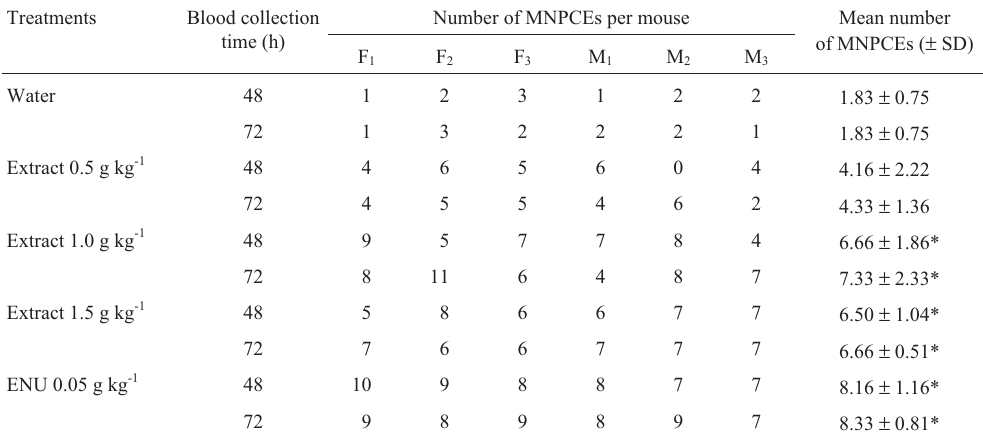
Table 4 - Micronucleus (MN) test results showing the number of micronucleated polychromatic erythrocytes (MNPCEs) in peripheral blood samples from female (n = 3; F 1 , F 2 and F 3 ) and male (n = 3; M 1 , M 2 and M 3 ) Swiss mice treated with a Piper cubeba seed extract. For each blood collection time 2000 cells were scored per mouse. SD = standard deviation. Negative control = water, positive control = N-nitroso-N-ethylurea (ENU).